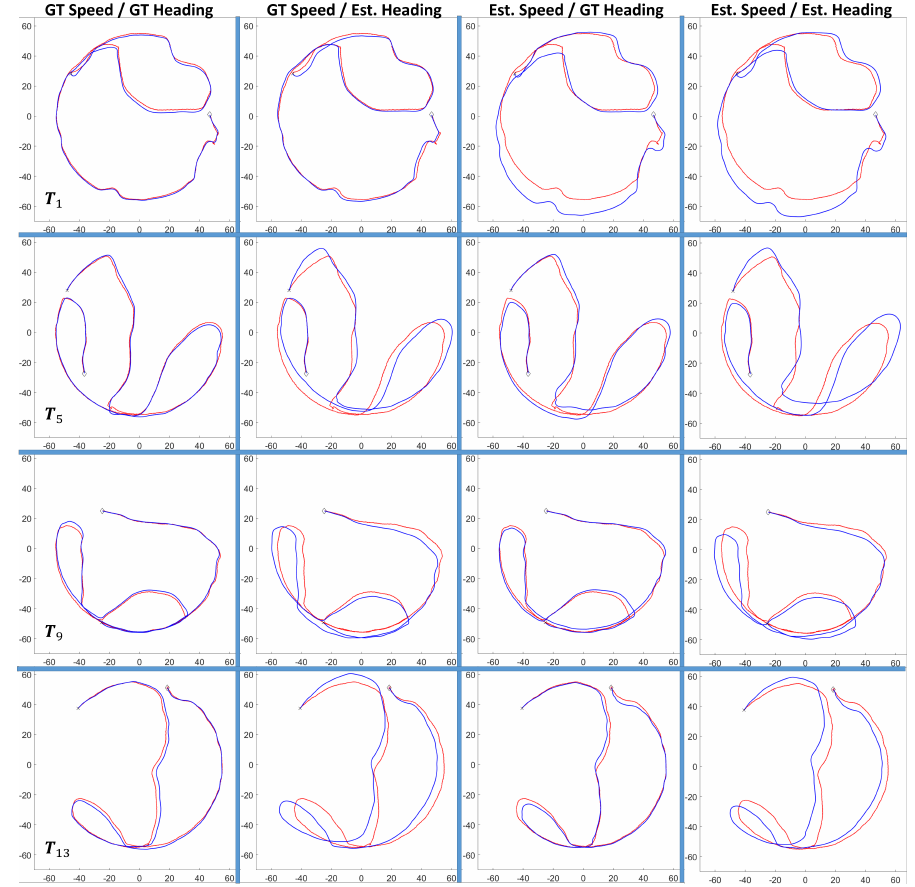
Figure 17. Estimated Trajectory Segments for Trial #7: Estimated position trajectories under varying conditions for Configuration C ψ , z . Each row is a two-minute trajectory segment and each column is a condition. The start point of the trajectory segment is denoted by a black ’x’ and the end point of the trajectory segment is denoted by a black diamond. The horizontal and vertical axes are in centimeters. Red Line: Ground truth trajectory. Blue Line: Estimated